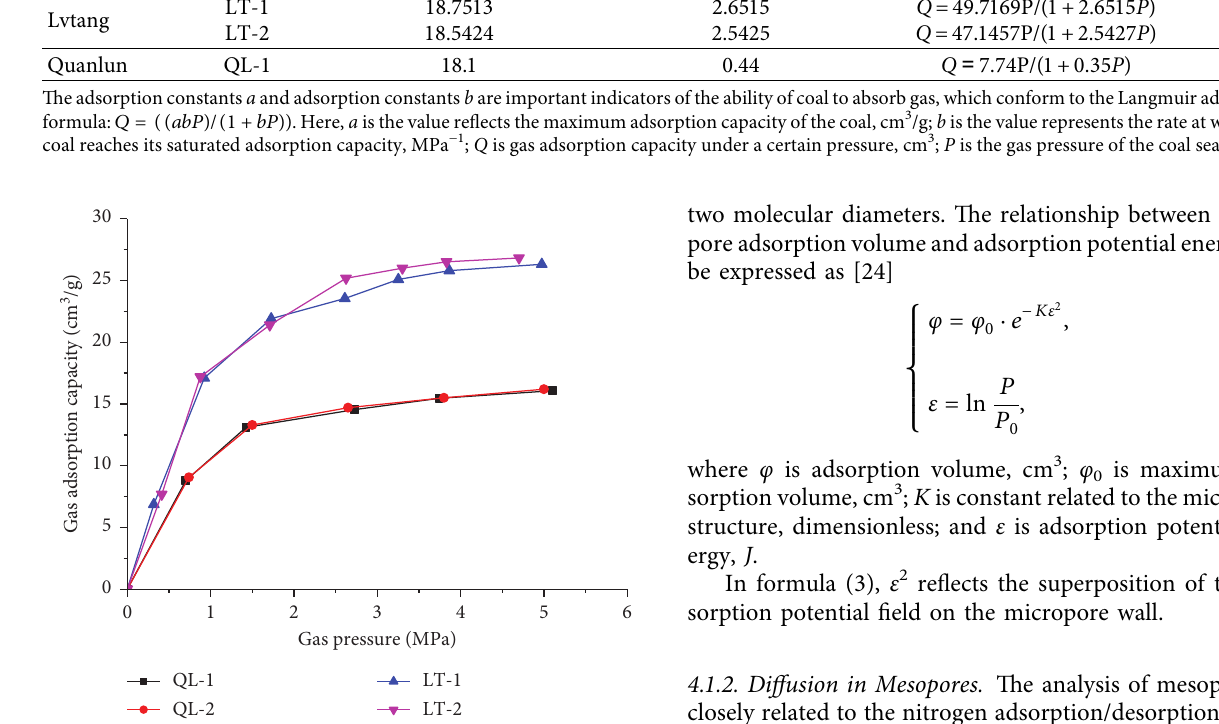
Figure 6: Constant temperature adsorption curve of soft and hard